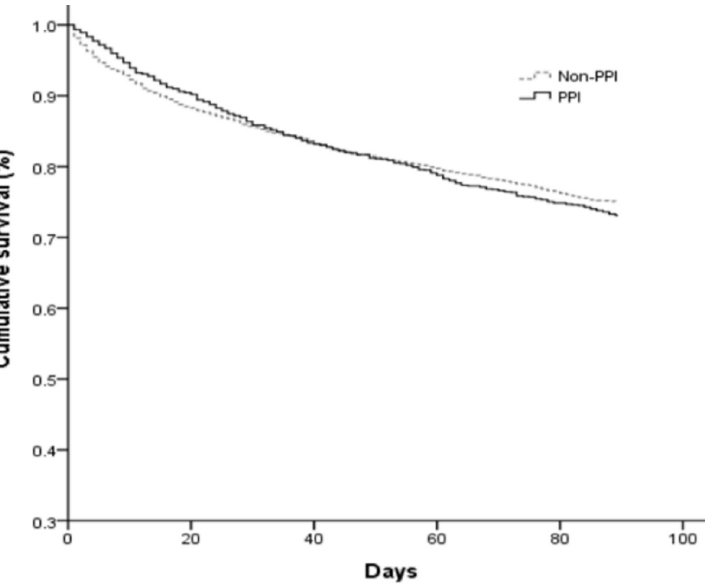
Fig 1. Cumulative survival plot for cirrhotic patients with pneumonia and between the PPI and Non-PPI